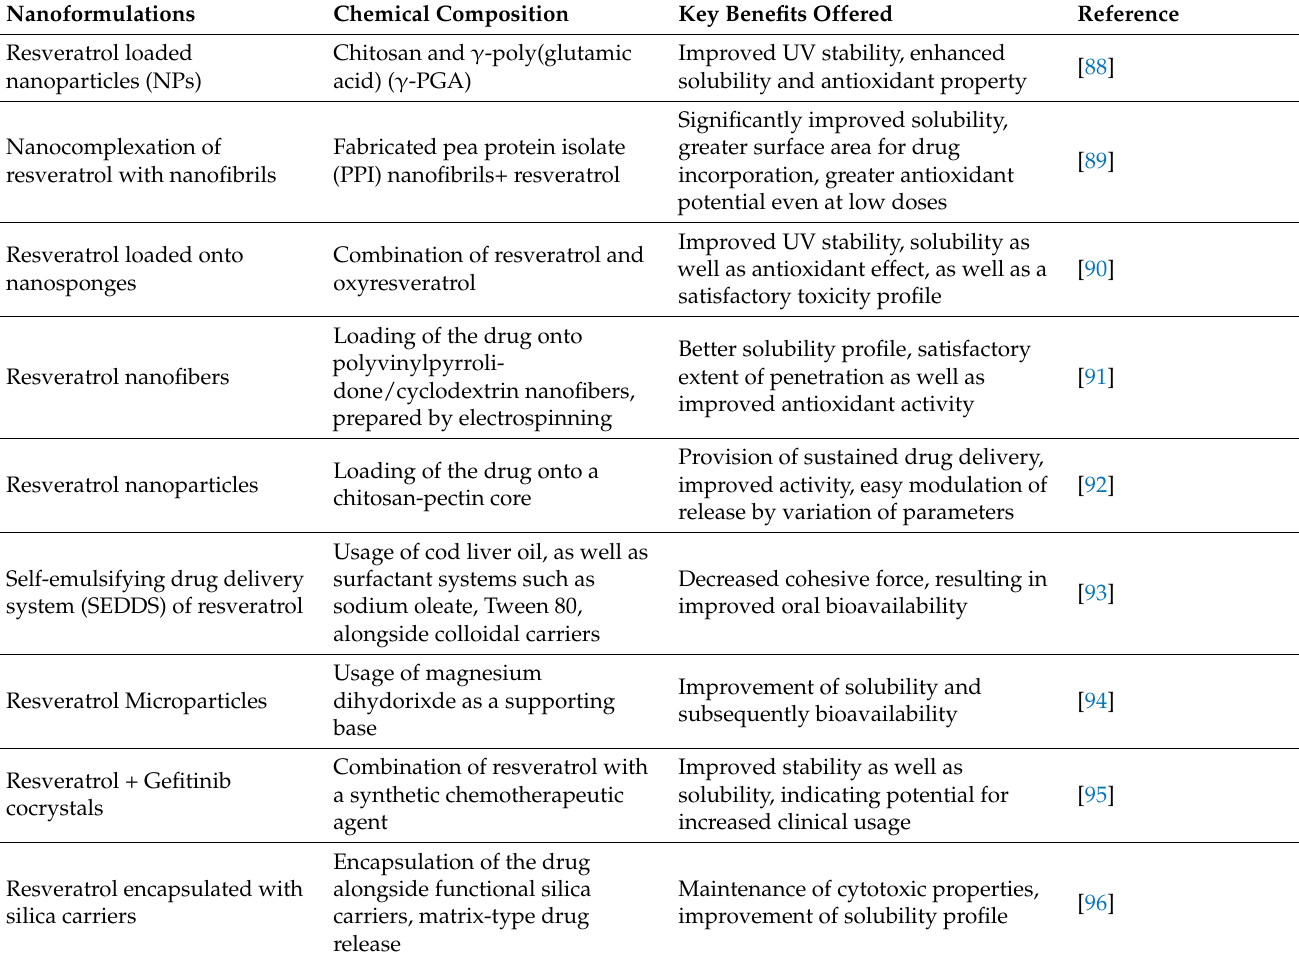
Table 2. Nanotechnological advancements in resveratrol delivery.